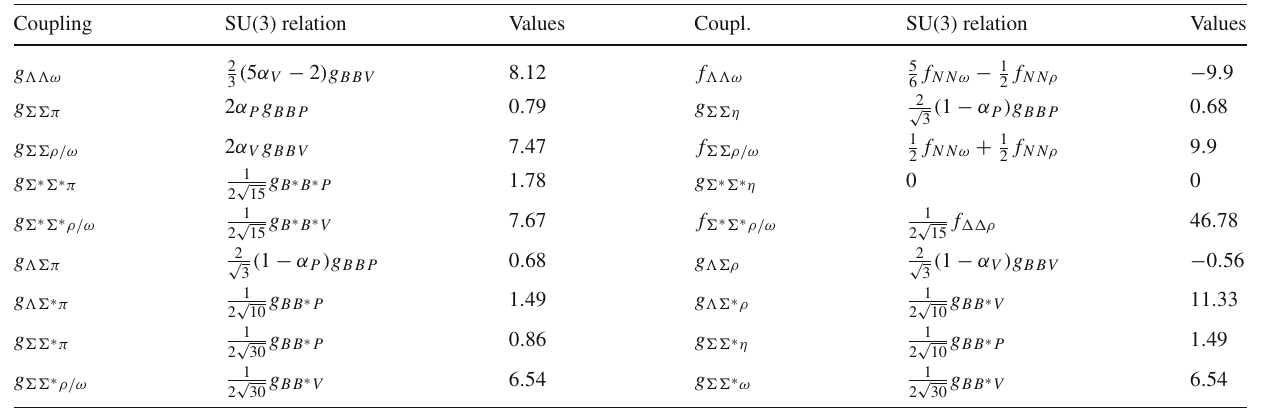
Table 1 The coupling constants in effective Lagrangians. Here, g